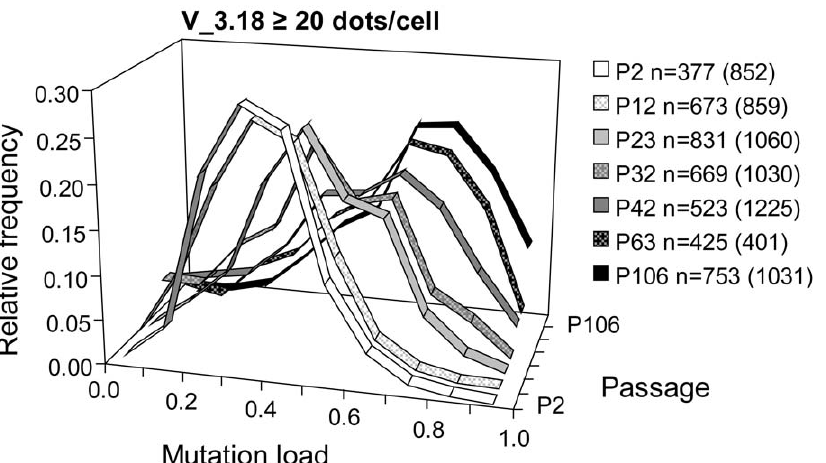
Figure 5. Cellular heteroplasmy evolution of V_50 P48 sub-clone V_3.18 by Padlock/RCA analysis. m.3243A . G mutation load of single cells of the sub-clone V_3.18 derived from V_50 P48 was assessed with Padlock/RCA. Relative frequency histograms of cells in 7 passages are shown. Since 3 of the 7 passages did not meet the criterion of . 30% of the cells having $ 40 dots/cell (see Figure S1), the relative frequency histograms are therefore shown at $ 20 dots/cell stringency and with 10% bin. n refers to the number of single cells evaluated in the histogram whereas numbers in parentheses represent the total number of cells analyzed.